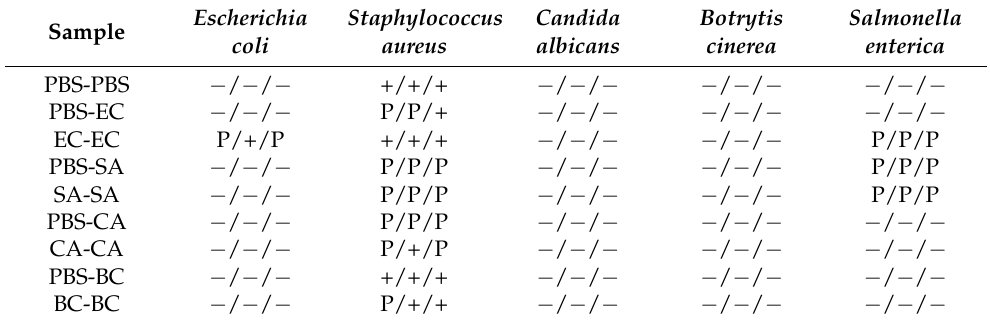
Table 3. In vitro antimicrobial activity of T. molitor hemolymphs against the different microorganisms.